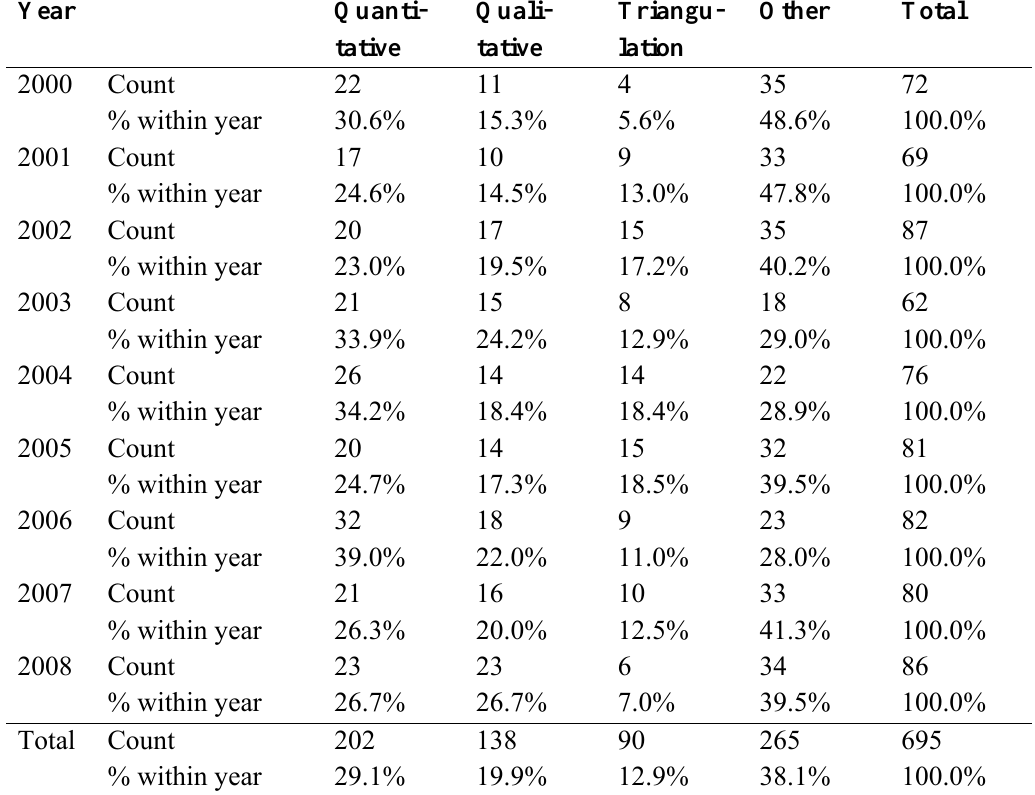
Frequency Tabulation of Methods used in Studies Published between 2000 and 2008 Year Quanti-